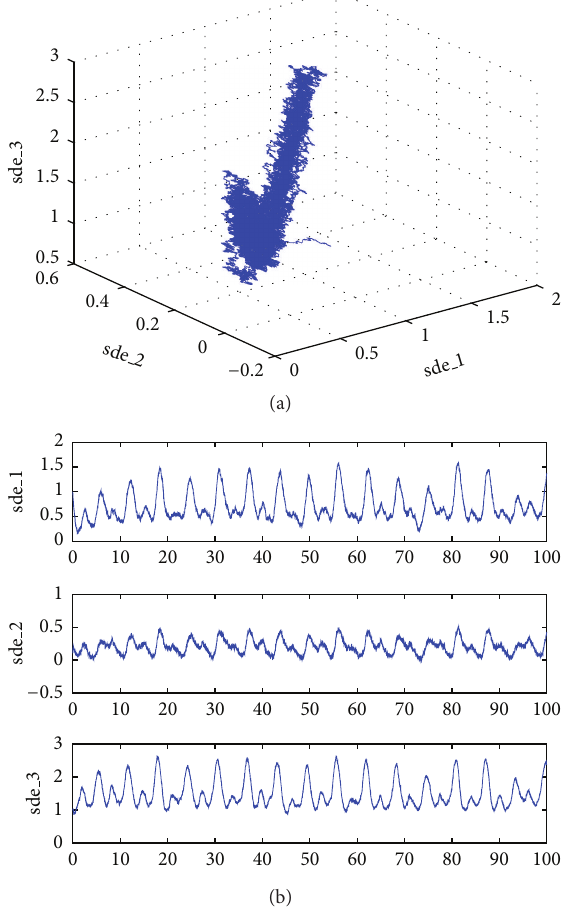
Figure 16: Stochastic system with a white noise 𝑢 𝑖𝑖 = 0.01 , 𝑖 = 1, 2, 3 .